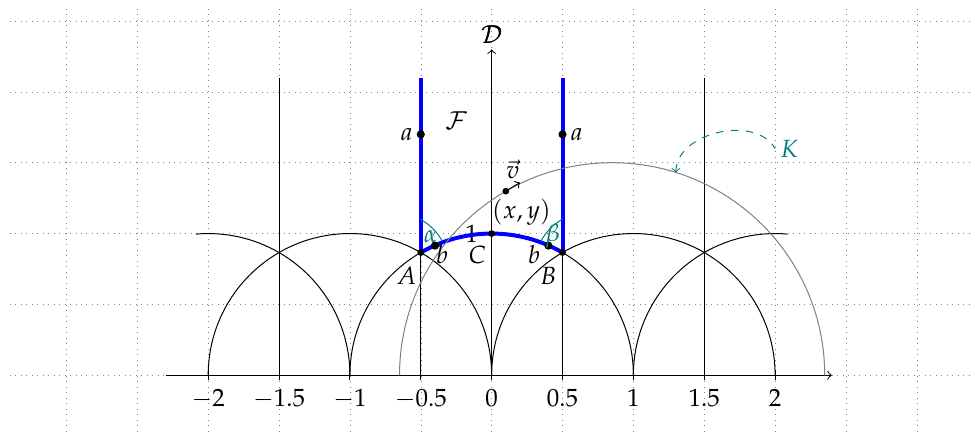
Figure 1. The non-compact fundamental region F of a finite area is represented by the hyperbolic triangle ABD . The vertex D is at infinity of the y axis and corresponds to a cusp. The edges of the triangle are the arc AB , the rays AD and BD . The points on the edges AD and BD and the points of the arcs AC with CB should be identified by the transformations w = z + 1 and w = − 1/ z in order to form a closed non-compact surface ¯ F by “gluing” the opposite edges of the modular triangle together. The hyperbolic triangle OAB can be considered equally well as the fundamental region. The modular transformations of the fundamental region F create a regular tessellation of the whole Lobachevsky plane by congruent hyperbolic triangles. The trajectory K is geodesic passing through the point ( x , y ) of F in the (cid:126) v